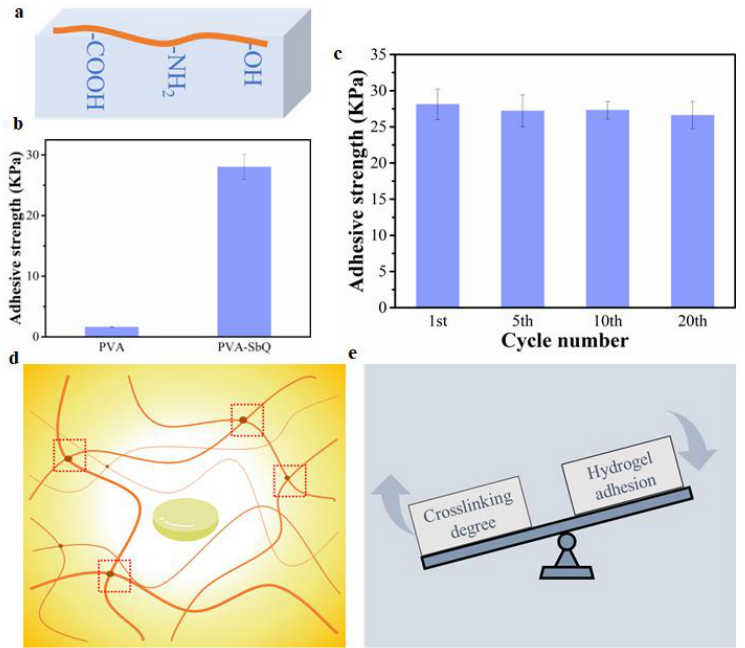
Figure 4. ( a ) The functional groups required for hydrogel adhesion generated by hydrogen bonds. ( b ) The maximum adhesive strength of PVA and PVA-SbQ hydrogels. ( c ) The adhesive strength of PVA-SbQ hydrogels under different stripping cycles. ( d ) The effect of crosslinking degree of hydrogels on chain movement. ( e ) The effect of crosslinking degree on hydrogel adhesion.